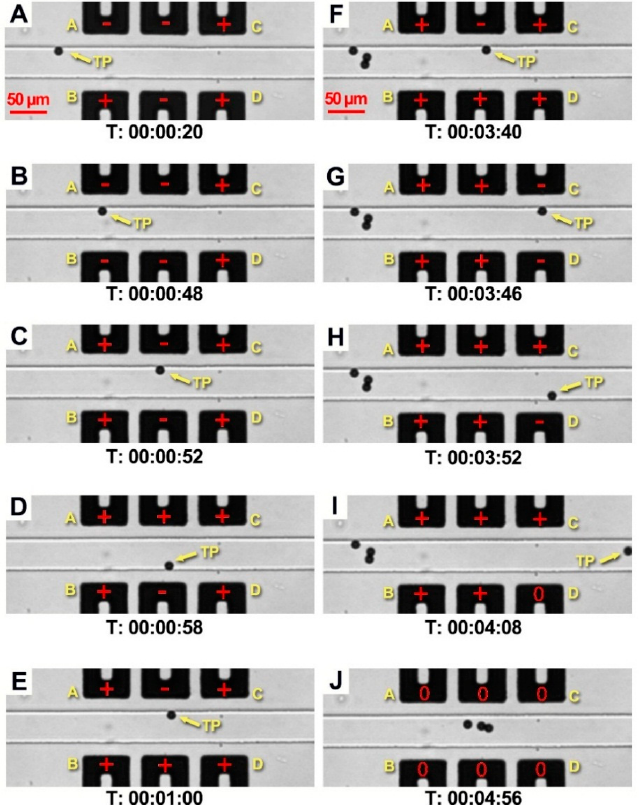
Figure 3. The process of the particle manipulation including: ( A – C ) the capture of the target particle (TP); ( D , E ) the manipulation of the target particle in the trap; ( F – I ) the release of the target particle; ( J ) the release of the other particles. The value of the electric potential applied on the positive electrodes is 700 V, negative electrodes − 700 V.